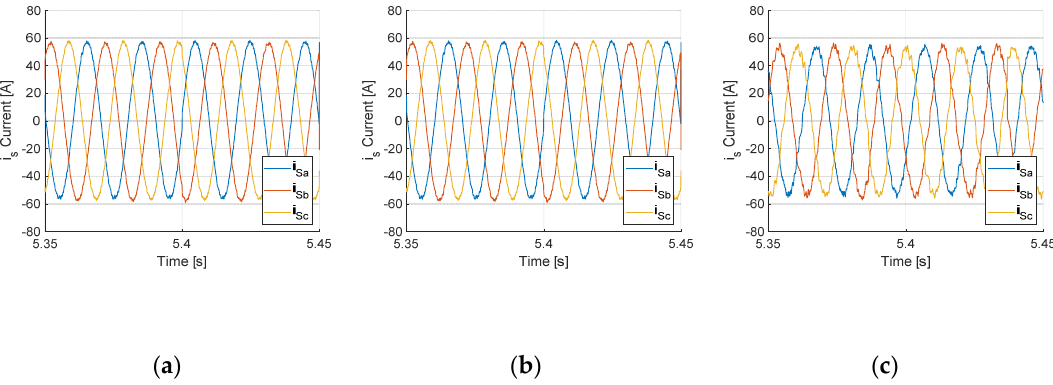
Figure 11. Three-phase grid currents: ( a ) CHB ( 4000 µ F ) ; ( b ) CHB ( 1200 µ F ) ; ( c ) CHB-SDC ( 1200 µ F ) .